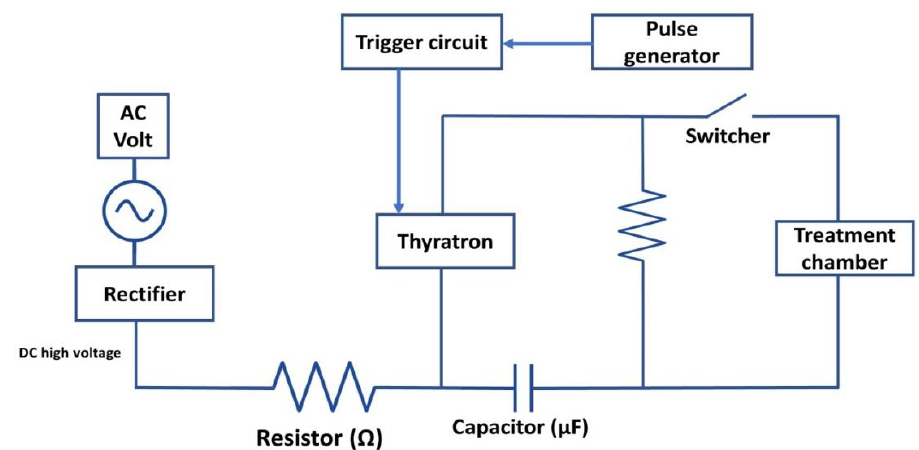
Description and Function(s)